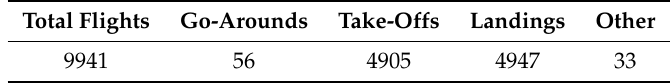
Table 2. Flight statistics for VABB during the comparison study period.